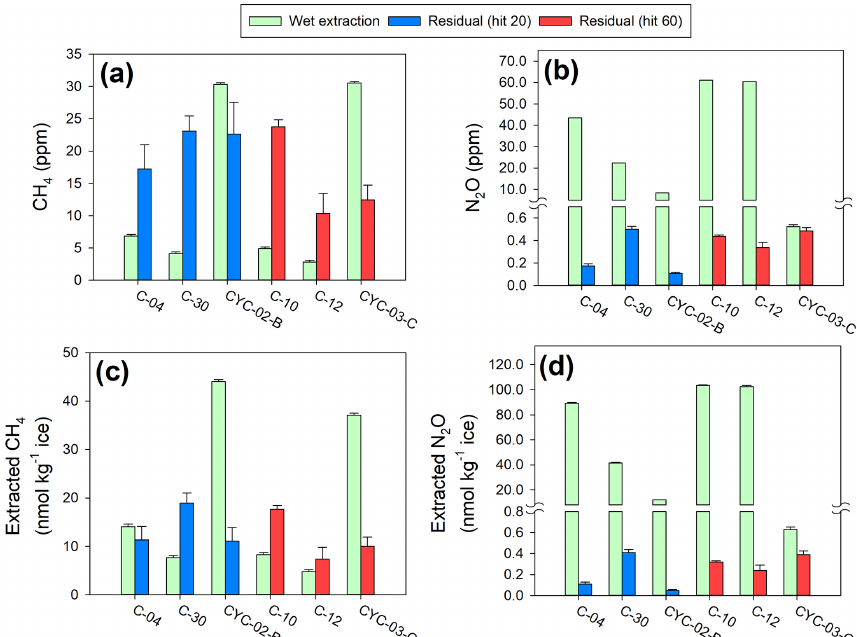
Figure 3. Comparison of wet-extracted gas and residual gas for CH 4 and N 2 O mixing ratios ( a and b ) and contents ( c and d ). The residual gas was extracted from the dry extraction method using the wet-degassed ice samples. The light green bars show the results of initial wet extraction, and the blue and red bars indicate the dry extraction of wet-degassed ice with 20 and 60 hits, respectively. The Cyuie samples are denoted as “CYC”, while “C” indicates the Churapcha